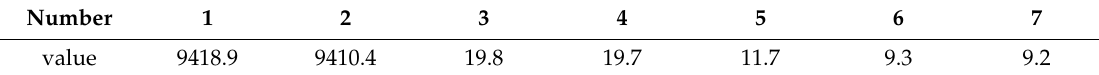
Figure 12. The first 3500 data of approximation coe ffi cient and detail coe ffi cients of y s in experiment. Table 5. Partial singular values of approximation coe ffi cient ca 4 in